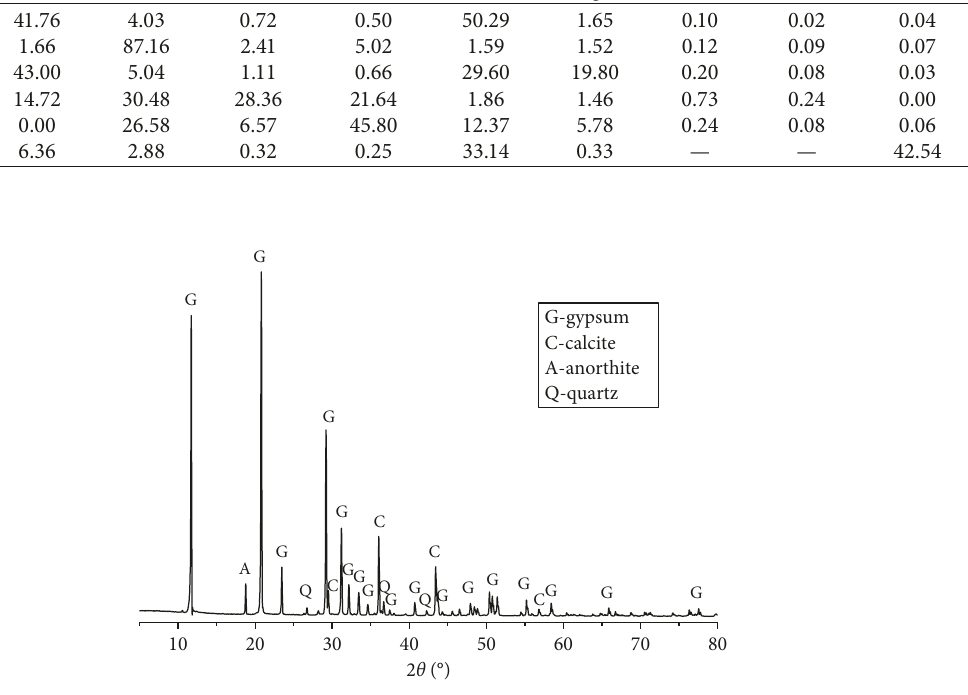
Figure 1: X-ray diffraction (XRD) pattern of gypsum. Table 2: Theoretic mineral composition of LHC clinkers